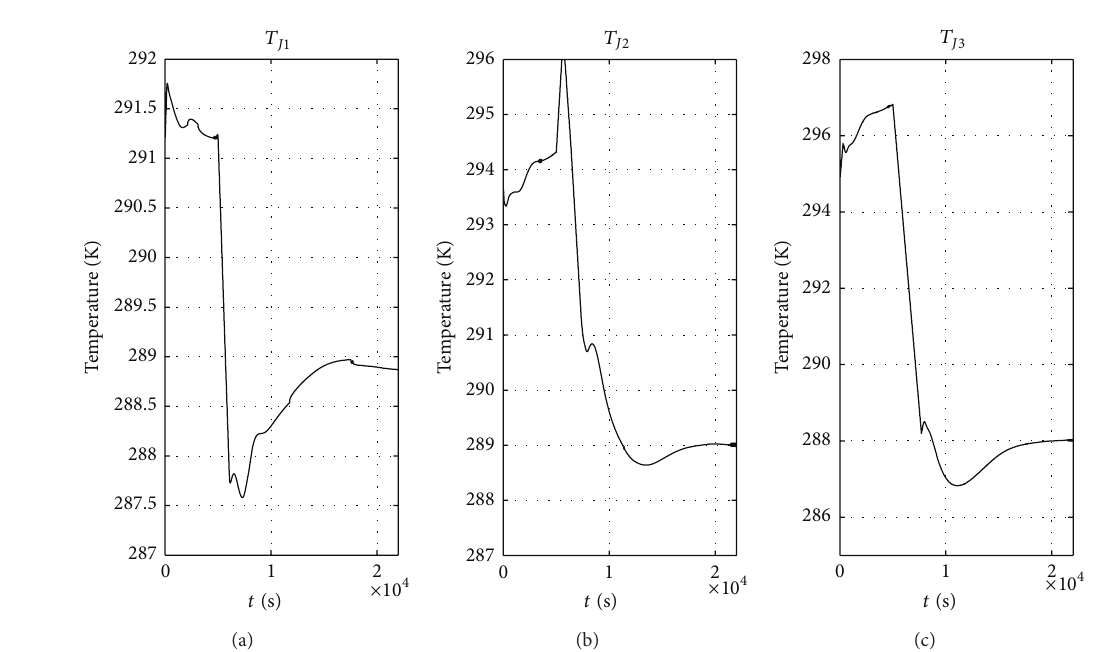
Figure 14: Control actions (jackets temperatures) of the MPC controller for Test 1.